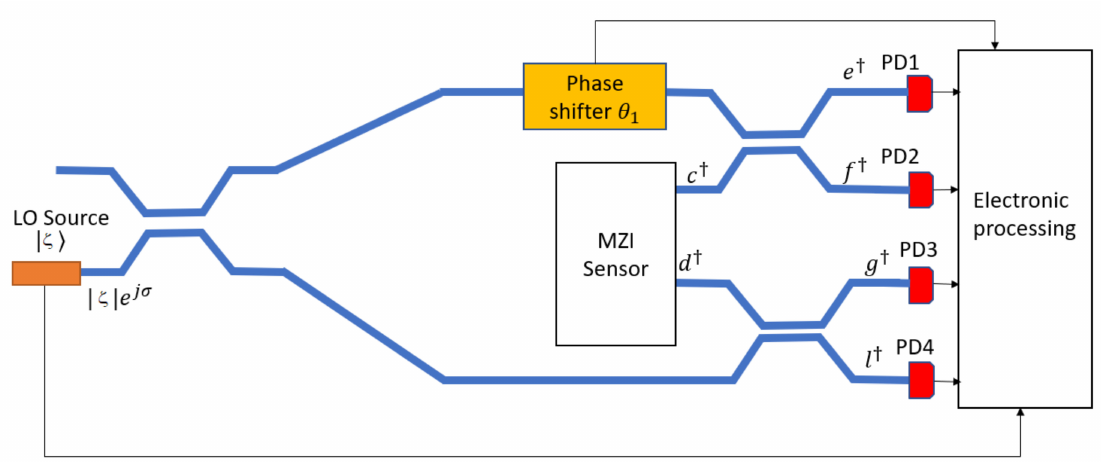
Figure 7. Integrated circuit for parity